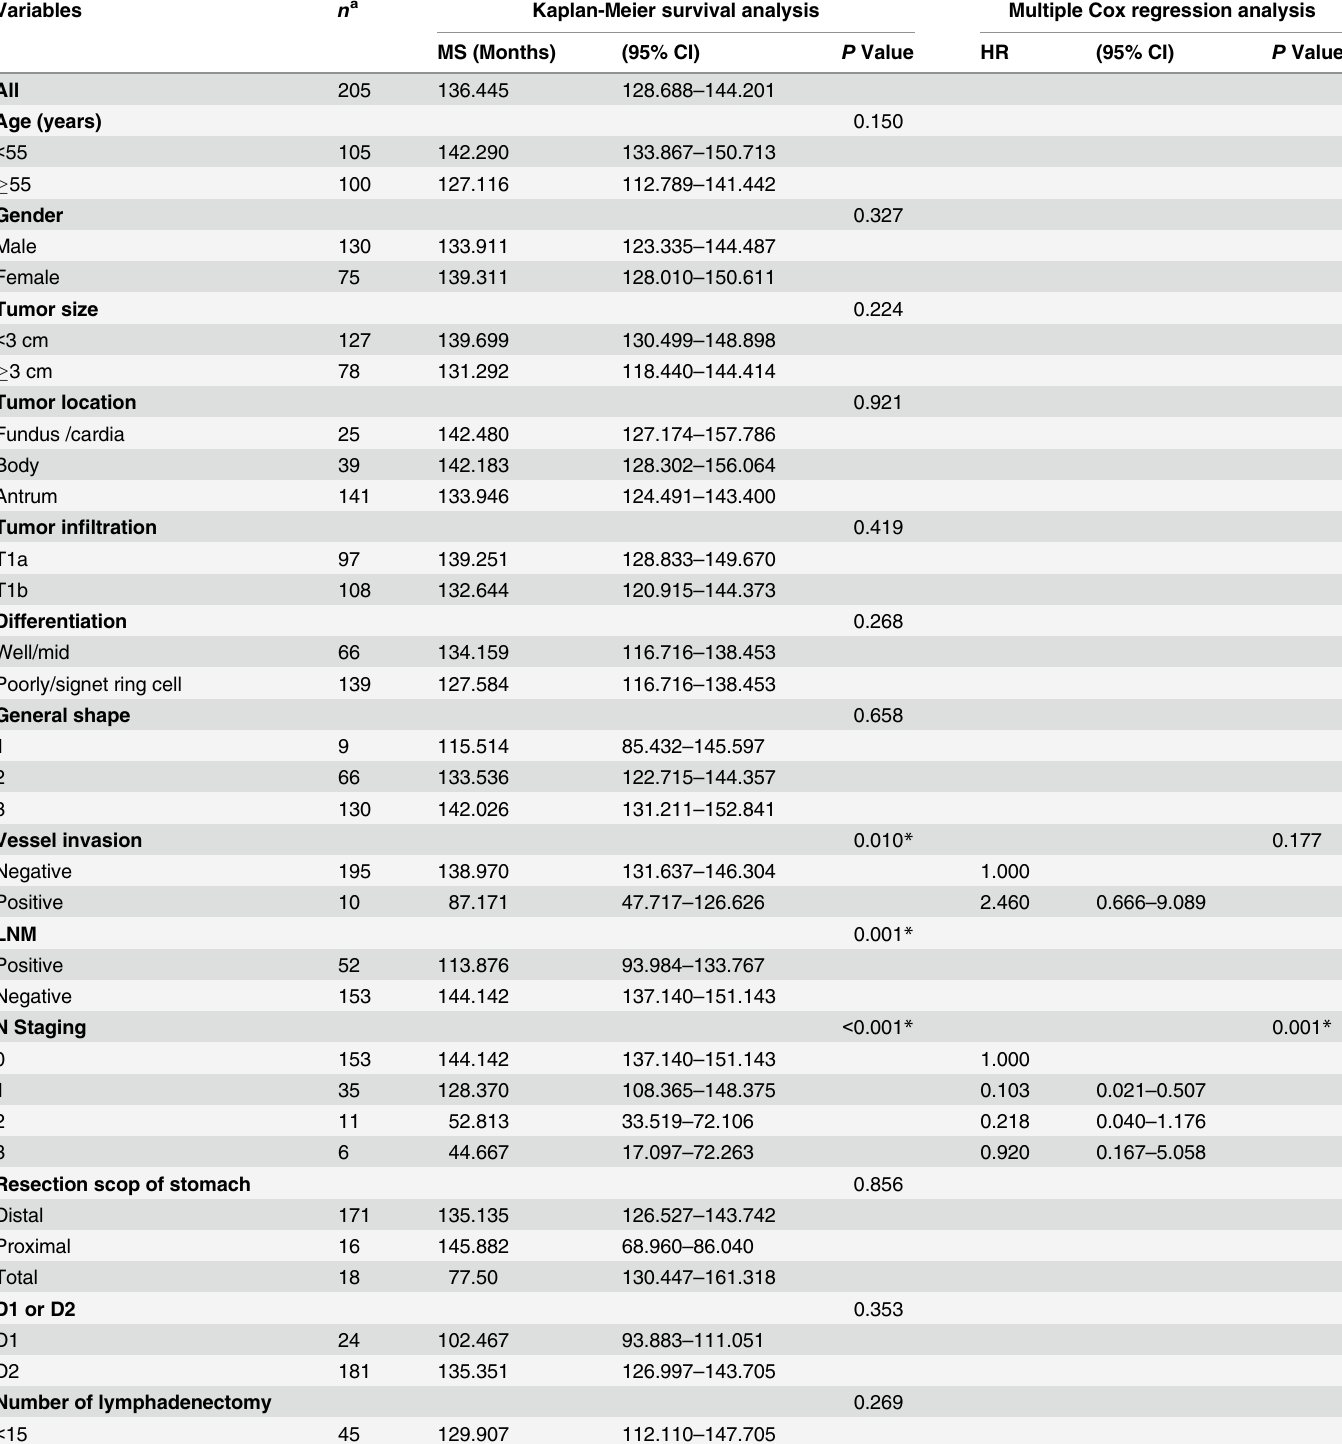
Table 3. Univariate and multivariate analyses of overall survival of